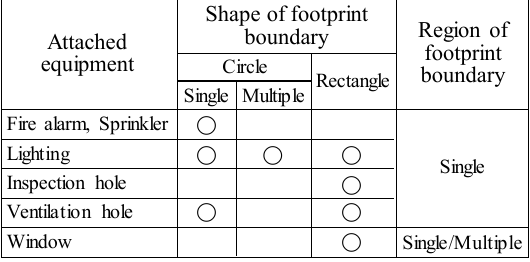
Table 1. Attached equipment and their